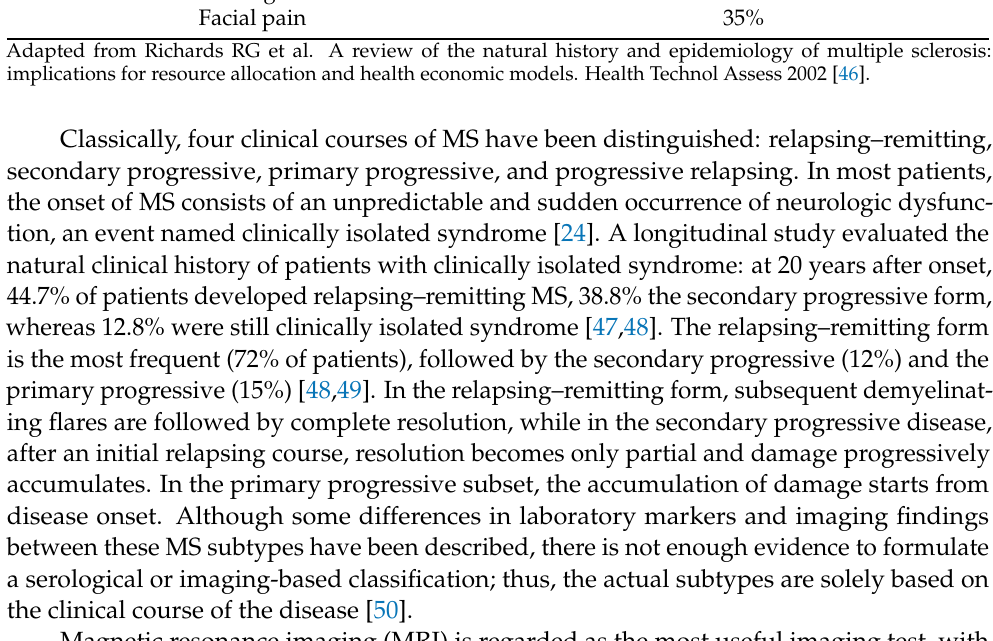
Table 2. Most common clinical manifestations of multiple sclerosis at any time during disease course. Weakness 89% Sensory disturbances 87% Gait disturbance 82% Bladder problems 71% Fatigue 57% Cramps 52% Diplopia 51% Other visual disturbances 49% Bowel disturbances 42% Dysarthria 37% Vertigo 36% Facial pain